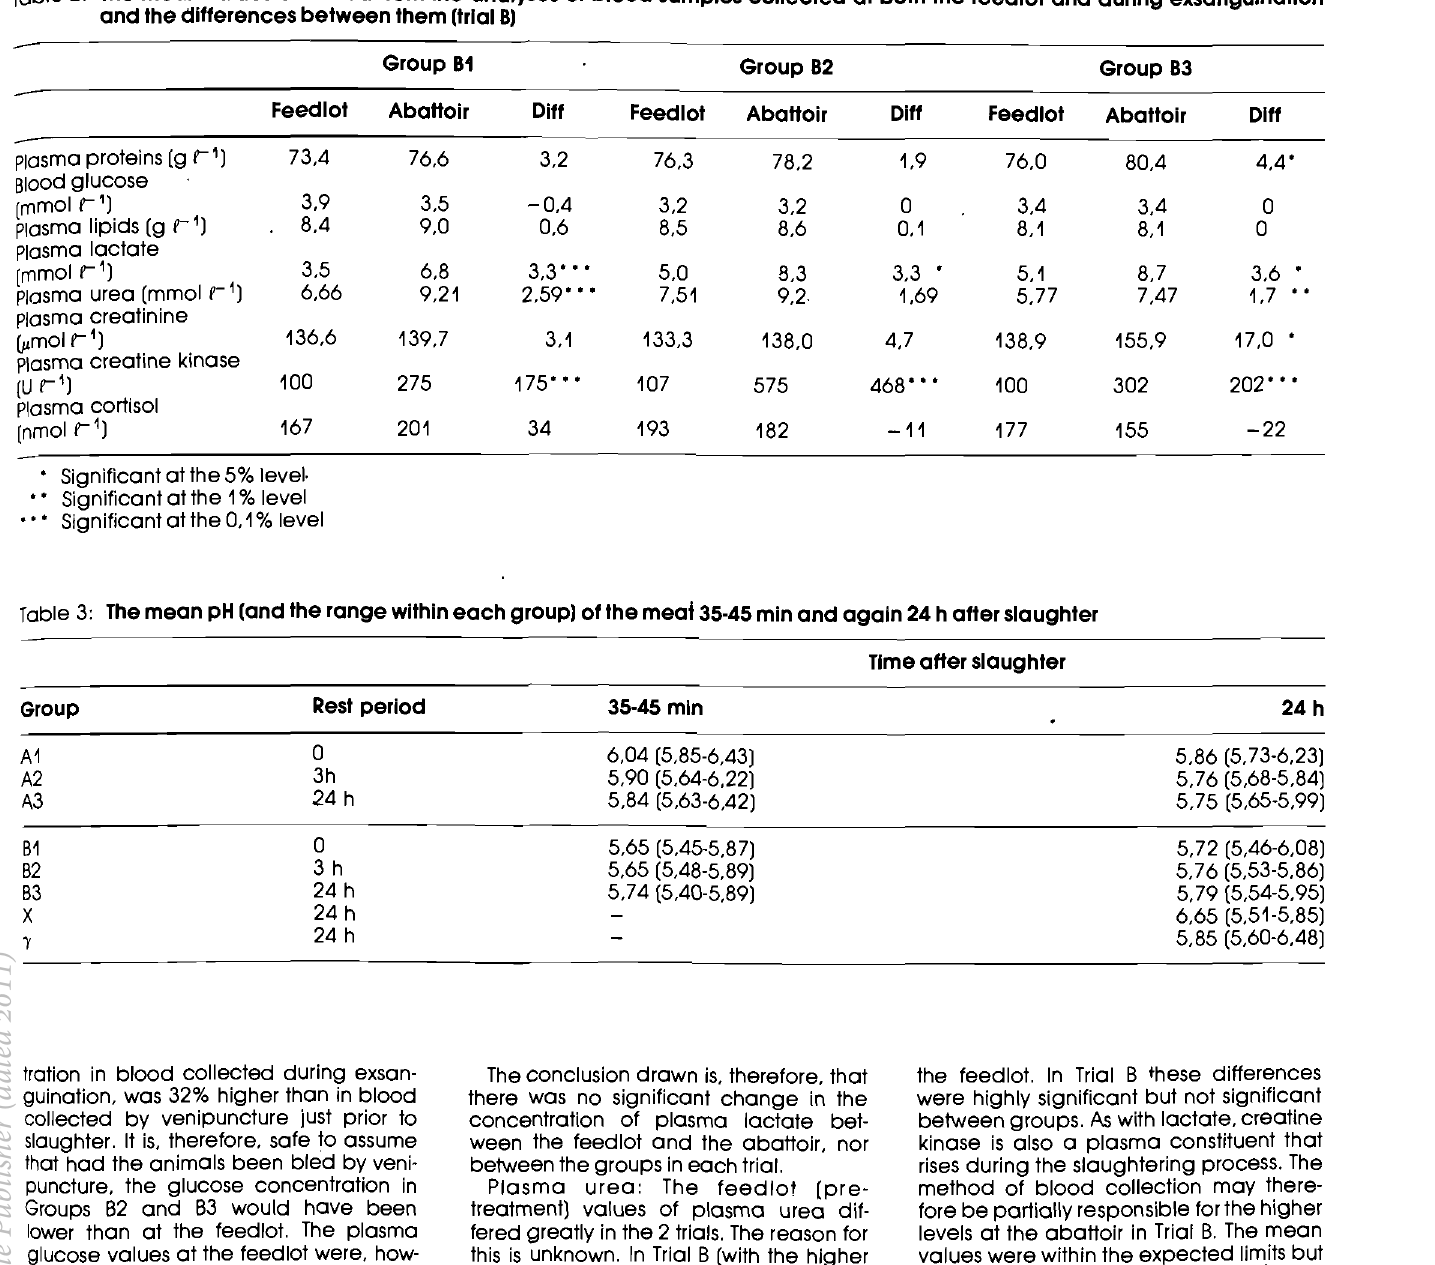
Table 2: The mean values obtained from the analyses of blood samples collected at both the feedlot and during exsanguination and the differences between them (trial B) Group B1 Group B2 Group B3 Feedlot Abattoir Plasma proteins (g e- 1) [mmol e-.').